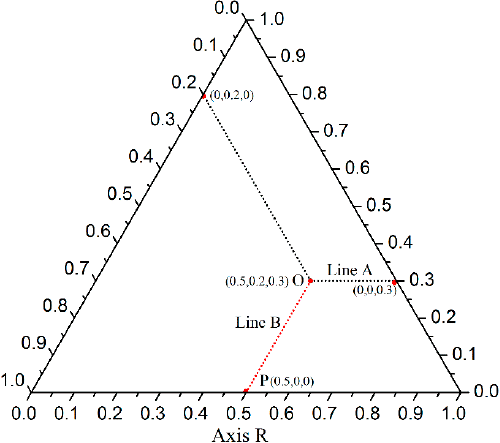
Figure 3. Schematic of the ternary triangular chart.